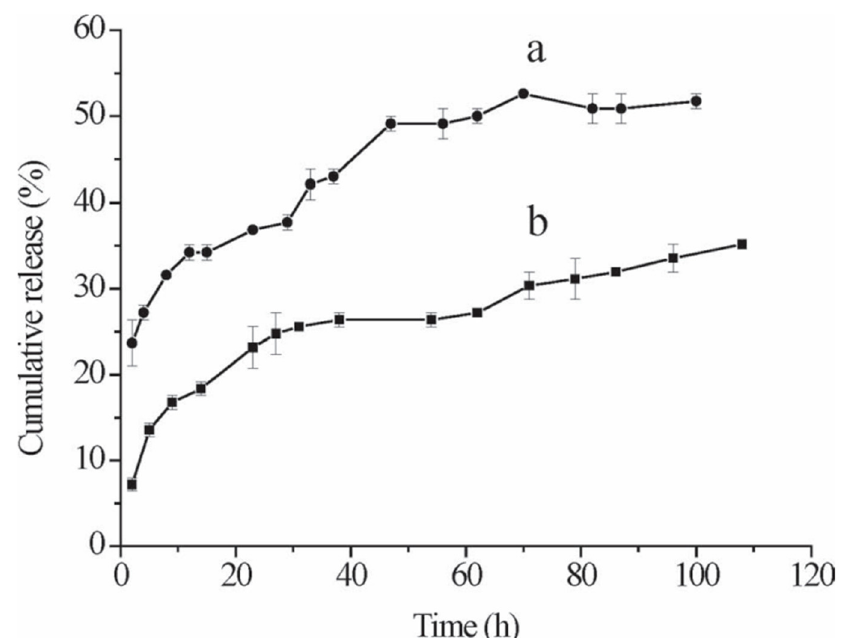
Figure 4. In vitro DOX release profiles from DOX-loaded into (a) wormlike brushes and (b) spherical micelles in a phosphate buffered saline (pH = 7.4, 37 ◦ C). Adapted from